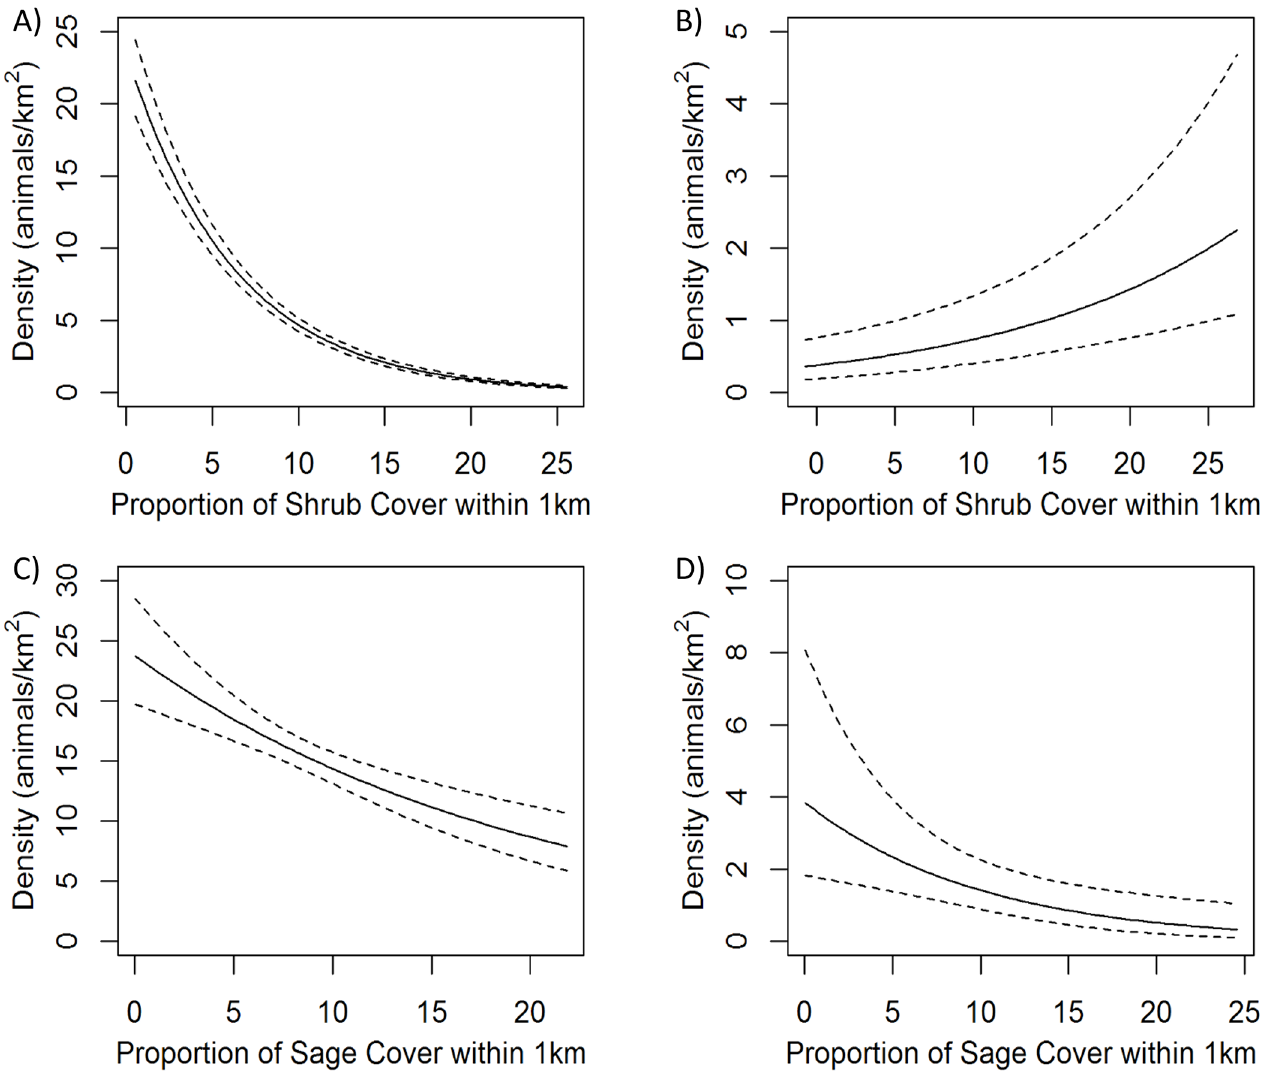
shows white-tailedprairiedogs, B) least chipmunks, C) Wyoming groundsquirrels,and D) leporids( Sylvilagus sp. and Lepus townsendii